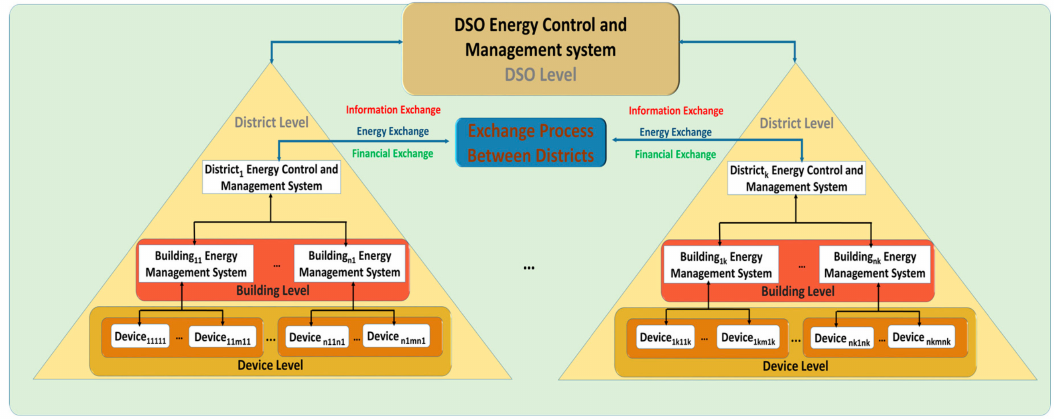
Figure 1. Topology of district management in the smart